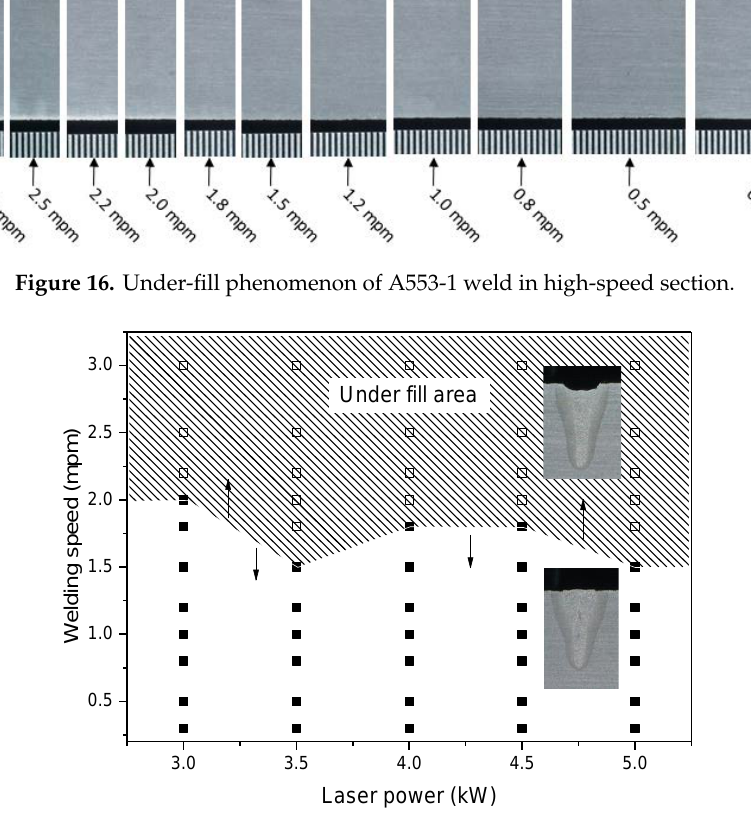
Figure 17. Under-fill section, according to welding speed.